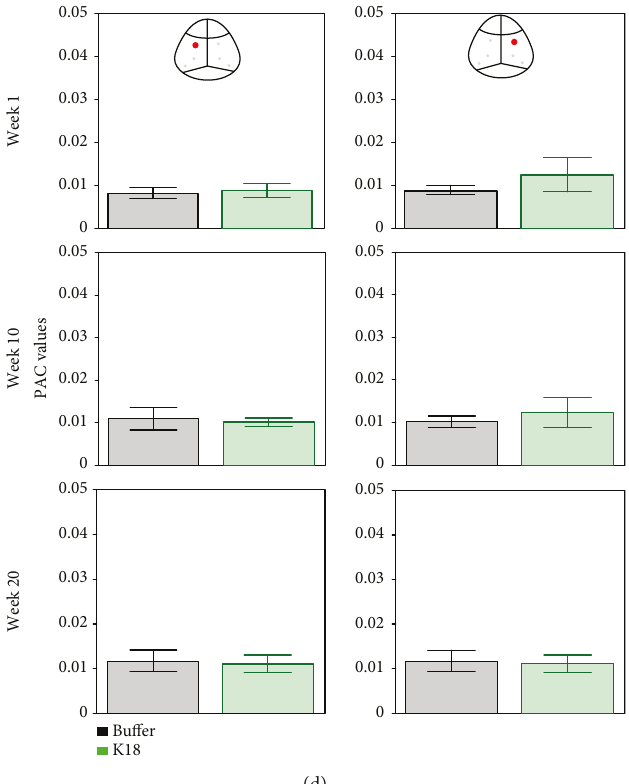
Figure 2: (a) Heat maps showing the mean phase-amplitude coupling (PAC) modulation index at the CA1L and CA1R electrodes for bu ff er-(black, n = 7 )andK18-(green, n = 8 )injectedmice,atrecordingweeks1,10,and20.Asshownbythecolorscale, “ hotter ” colorsindicate high coupling values while “ colder ” colors indicate low or no coupling. Bar graphs showing the mean (across animals) theta-gamma PAC (with 95%CI)attheCA1LandCA1Relectrodesforbu ff er-(black, n = 7 )andK18-(green, n = 8 )injectedmice,atrecordingweeks1,10,and20.These means along animals ’ PAC values are calculated as the average PAC for the window of phase frequency: 3.5 – 12.5 Hz, and amplitude frequency: 32 – 100 Hz, to focus on theta-gamma PAC. Horizontal lines above the bar plots with asterisks indicate the presence of signi fi cant di ff erence between bu ff er- and K18-injected animals (two-sample t -test; ∗ p value < 0 05 and ∗∗ p value < 0 01 ). (b) Averaged across animals ’ variations in gamma amplitude (vertical axes) as a function of theta phases (horizontal axes) obtained from the electrodes implanted in CA1L and CA1R for the weeks 1, 10, and 20 postadministration of the bu ff er and K18. Right plots show estimated phase shifts in obtained oscillations for each animal (shown as dots) and condition (bu ff er (black) and K18 (green) injected). Radii show circular mean values for bu ff er- and K18-injected groups of animals. No signi fi cant di ff erence in means between groups across all time points was found with the Watson-Williams test. (c) Scatter graphs show mean theta-gamma PAC at the contralateral (CA1L) and ipsilateral (CA1R) CA1 regions of the K18 injection site, for all recording weeks, demonstrating changes in PAC over time, for the bu ff er-injected (black) and K18-injected (green) groups. Time intervals with signi fi cant di ff erences ( p < 0 05 , two-sample t -test) between bu ff er-injected and K18-injected animals are shown by a horizontal line. (d) Bar charts quantifying the mean PAC in frontal electrodes for bu ff er- (black) and K18- (green) injected animals. Note that no signi fi cant di ff erence (two-sample t -test) was observed between the study groups. Data are presented as mean values (with 95% Figure 2(a), left bar plots, bu ff er-injected animals demon- strate equivalently (no statistical di ff erence, two-sample test) high phase-amplitude coupling in both ipsilateral CA1R and contralateral CA1L regions, at recording weeks 1, 10, and 20.